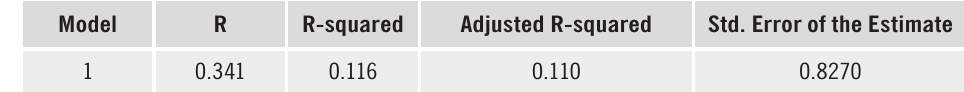
Table 9. Summary of the regression model – level of market orientation and competitiveness index